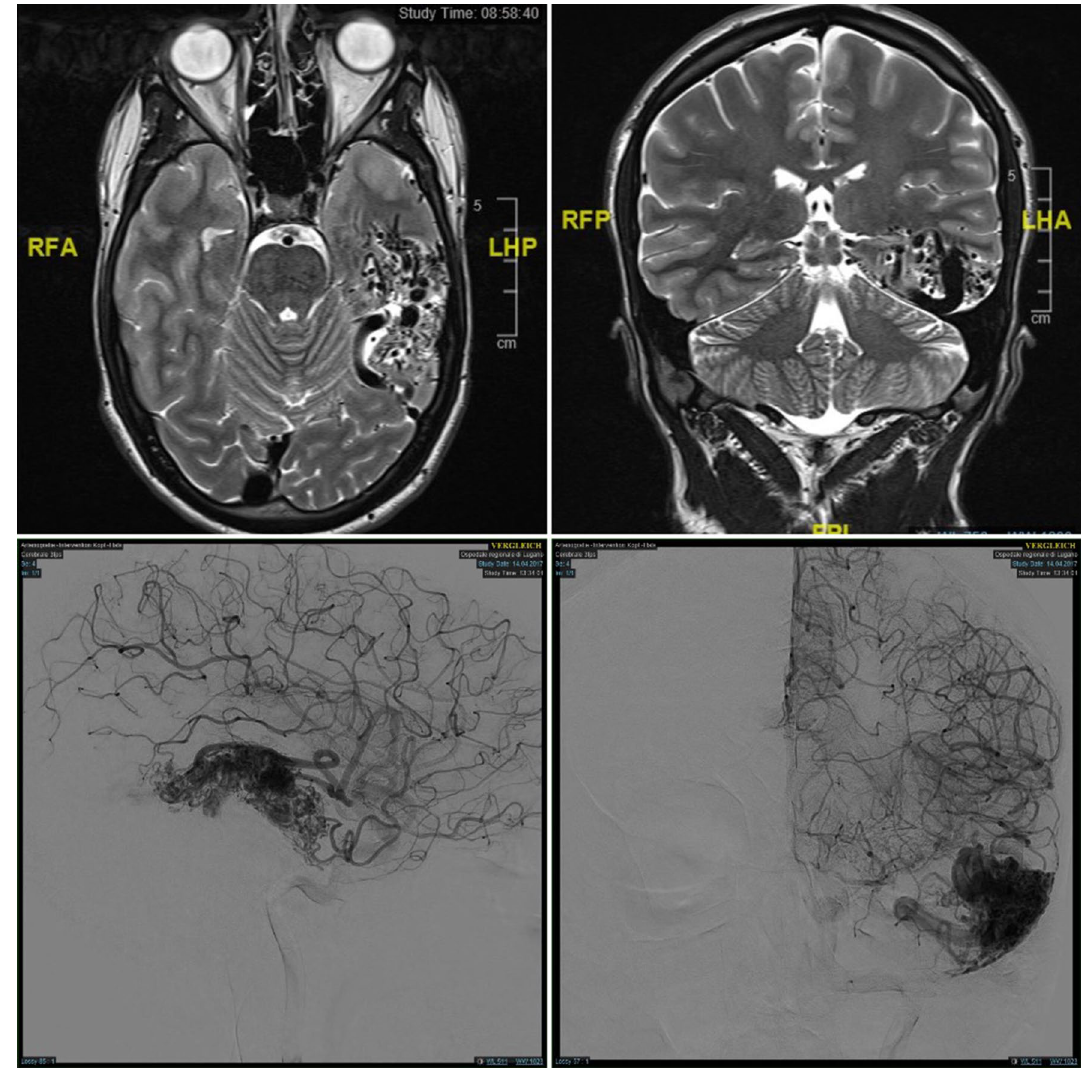
Fig. 2 T2-MRI with GD in axial (upper level, left) and in coronal (upper level, right) and initial DSA in sagittal (lower level, left) and in coronal (lower level, right) showing the temporal AVM from